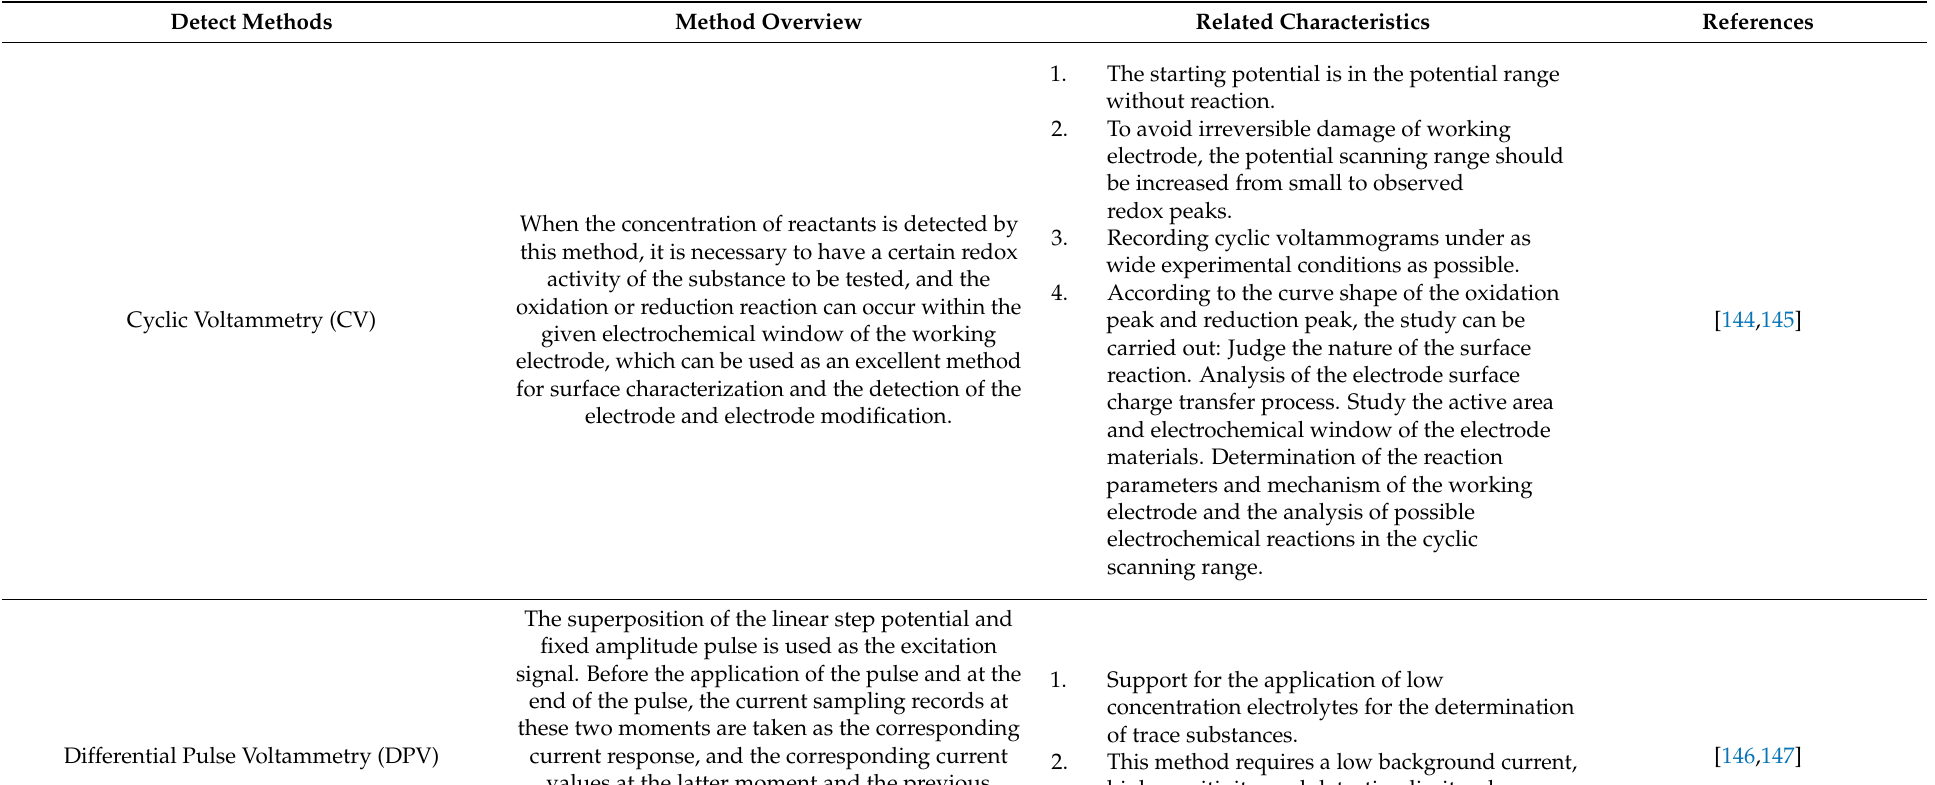
Table 4. A comparison of the electrochemical detection method of the wearable sweat sensor included in this paper with other common